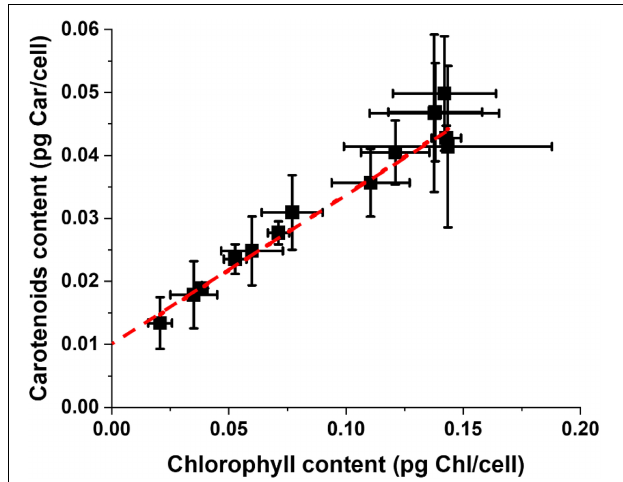
FIGURE 4 | Carotenoids and Chlorophyll content of Nannochloropsis cells cultivated in a plethora of lab-scale conditions. Data were treated independently from the environmental parameters of the different growth conditions of Supplementary Table 1 .